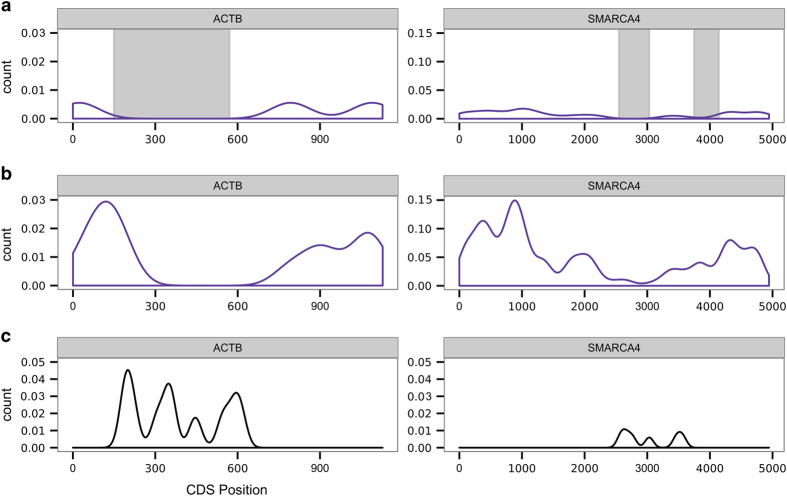
Missense-depleted regions in genes using population exomes. (a) Missense variant site density plots along the coding sequence length of ACTB or SMARCA4 from ~6,500 sequenced exomes from ESP. Grey-shaded regions indicate candidate missense-depleted regions (MDRs) that lack missense variants but that have synonymous variants. (b) Missense variant plots for ACTB and SMARCA4 using ~60,000 exomes from ExAC data, further delineate MDRs. (c) Density plots of pathogenic missense variant sites from ClinVar.